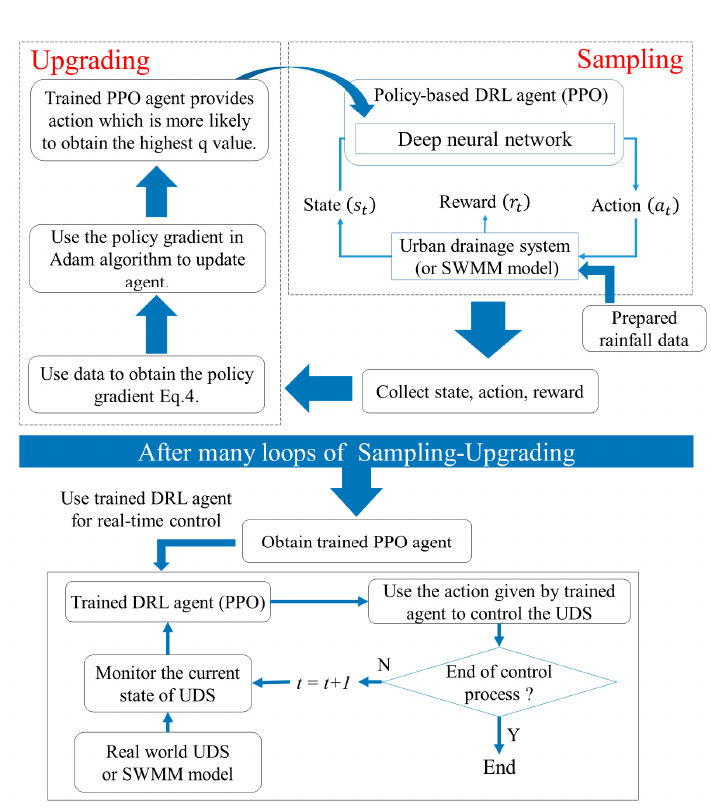
Figure 3. The training and implementation of PPO in a simulated environment.